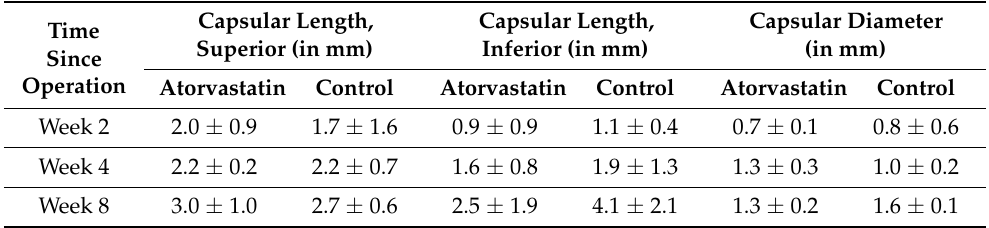
Table 2. Length and diameter of posterior joint capsule (presented as mean and standard deviation in